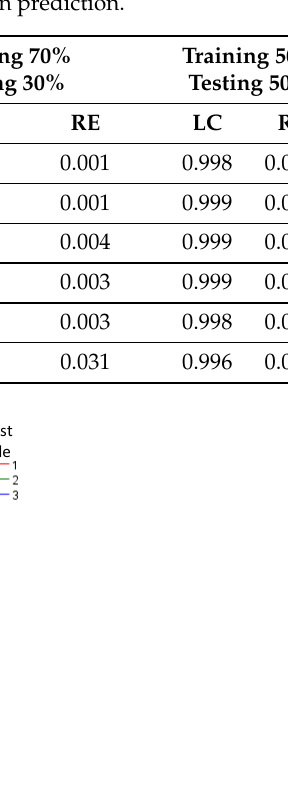
Table 4. Evaluation metrics of the best algorithms for consumption prediction.